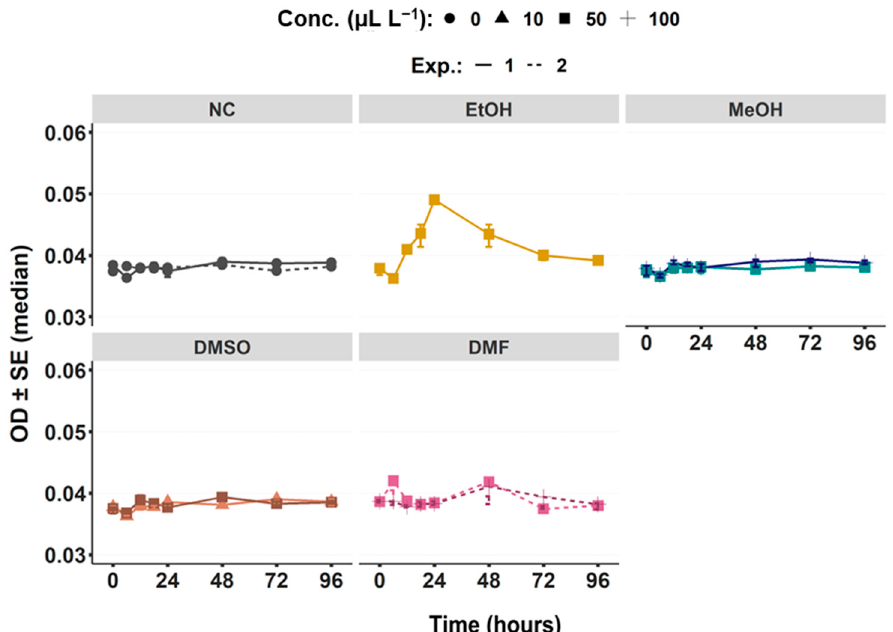
Figure 2. Measured water turbidity (i.e., optical density (OD), at 600 nm) within 96 h renewal inter- vals for the negative control (NC) and the solvent experiments (i.e., ethanol (EtOH), methanol (MeOH), dimethyl sulfoxide (DMSO), and dimethyl formamide (DMF)).